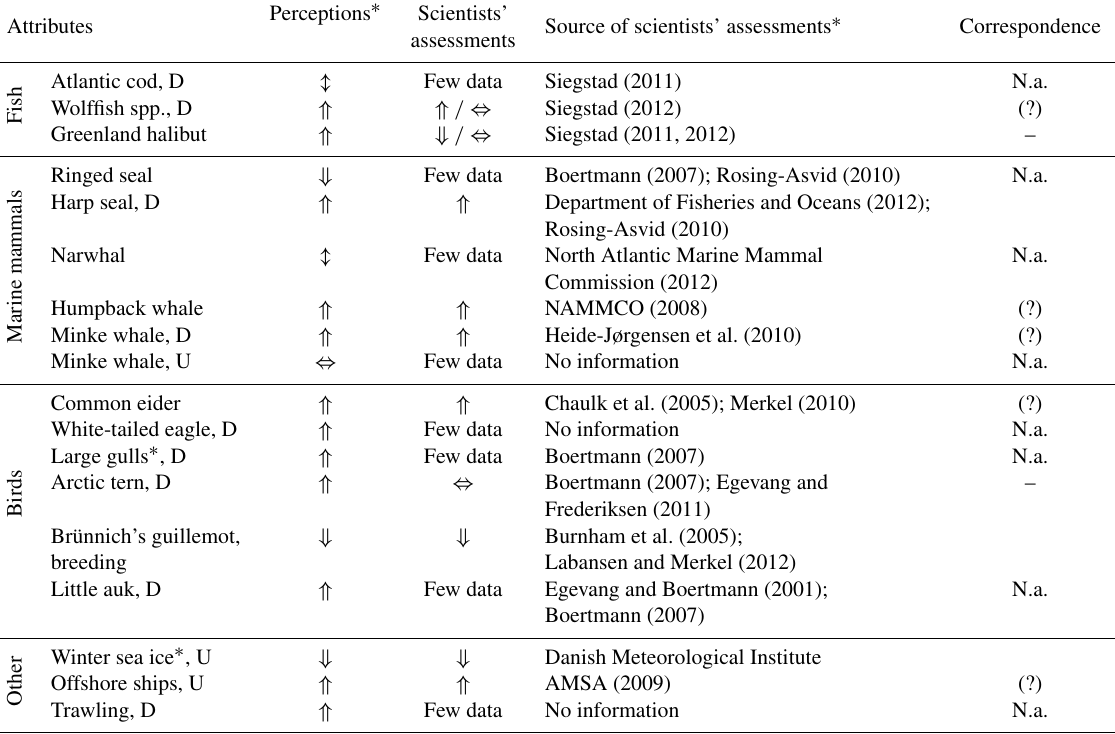
Table A2. Comparison of community members’ perceptions and trained scientists’ assessments of trends in the abundance of 18 marine attributes in NW Greenland during 2009–2011 (Danielsen et al.,